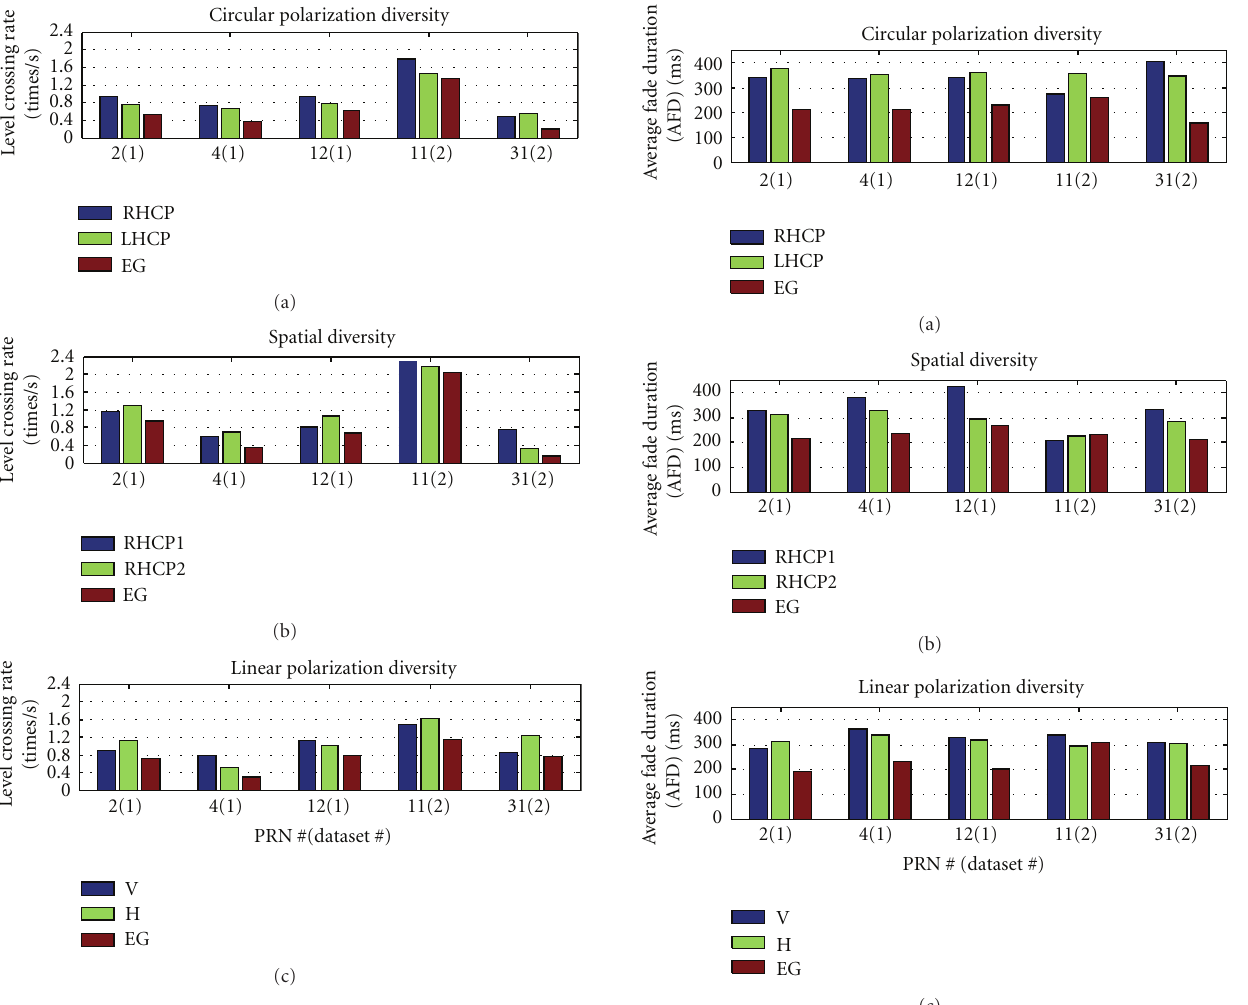
Figure 10: LCR analysis for single branches and di ff erent diversity structures (V and H stand for vertical and horizontal linearly polarized antennas).